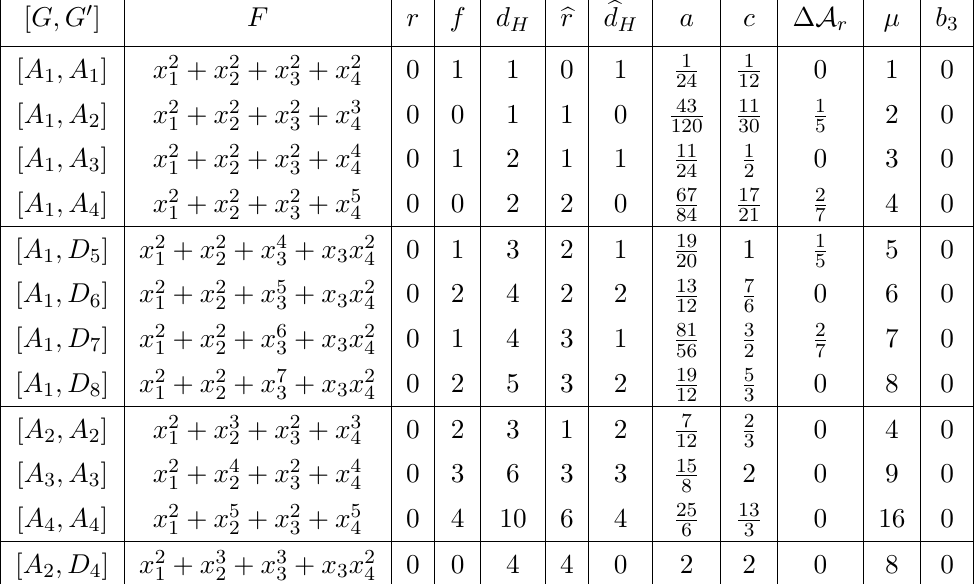
Table 5 . 5d and 4d data for some singularities giving rise to T 4d the conformal anomalies of T 4d The Higgs branch